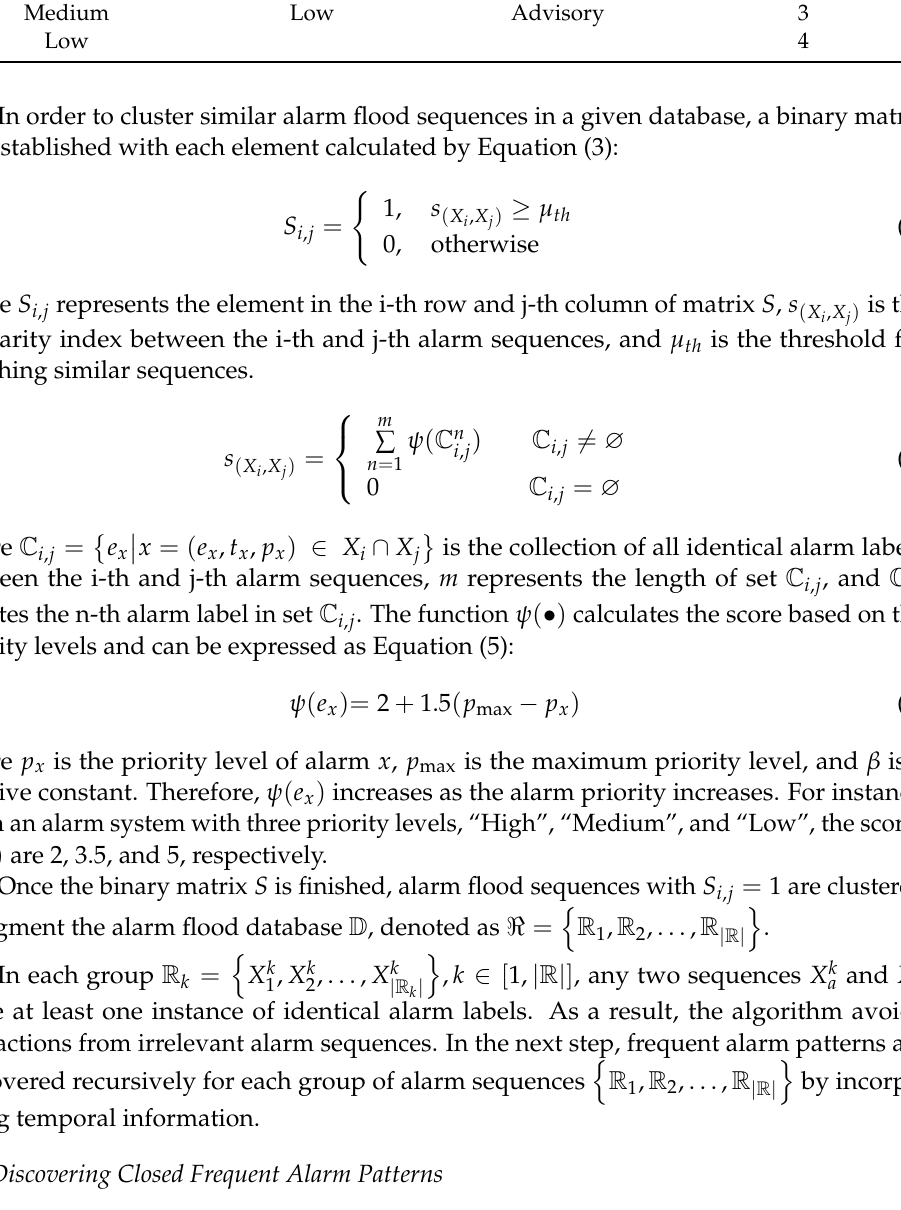
Table 4. Typical alarm priorities of industrial alarm systems. Type 1 Type 2 Type 3 Emergency Emergency Critical 1 High High Warning 2 Medium Low Advisory 3 Low